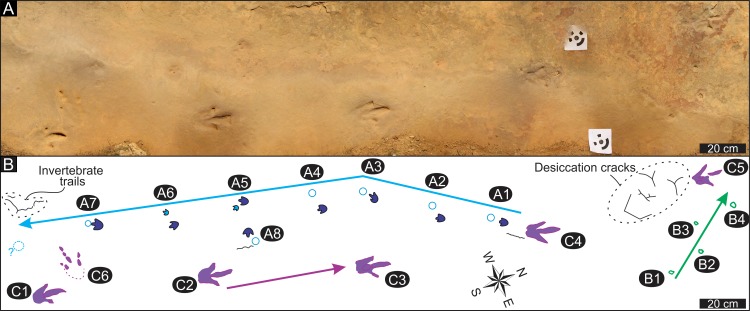
Trackways at the Highlands ichnosite.(A) Orthophotograph of the palaeosurface. (B) Interpretive outline map of the palaeosurface indicating the trackway patterns, invertebrate trails and desiccation cracks. Trackway A–blue; Trackway B–green; Trackway C–purple. Arrows show locomotion directions.